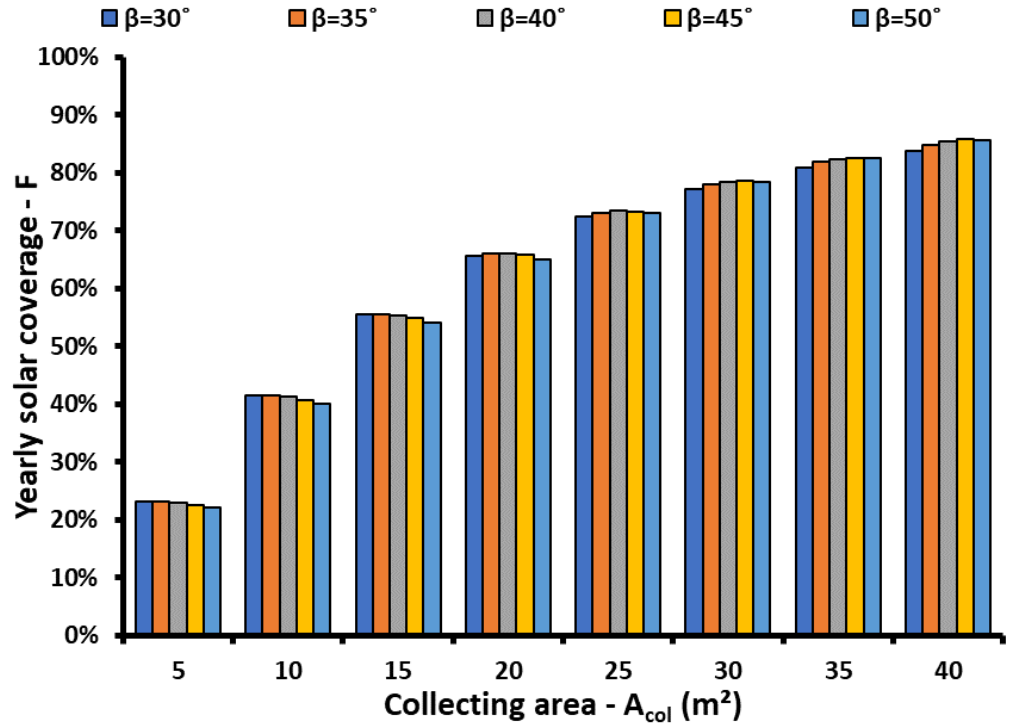
Figure 4. The impact of the solar field area and of the tilt angle on the yearly solar coverage for Athens and the simple FPC.